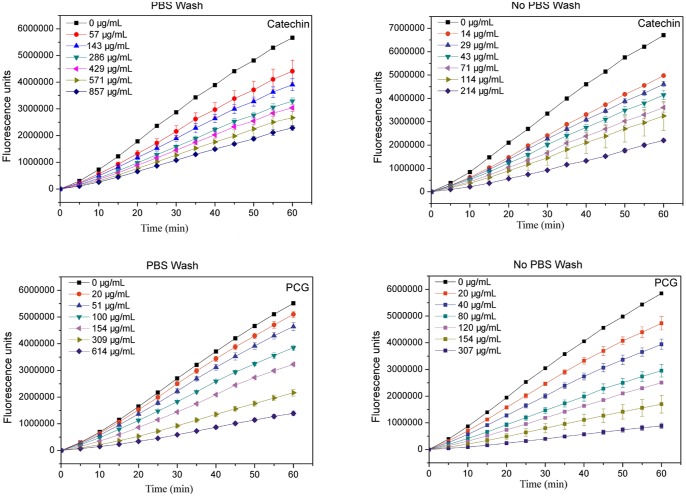
Peroxyl radical-induced oxidation of DCFH to DCF in HepG2 cells and the inhibition of oxidation over time by catechin and PCG.